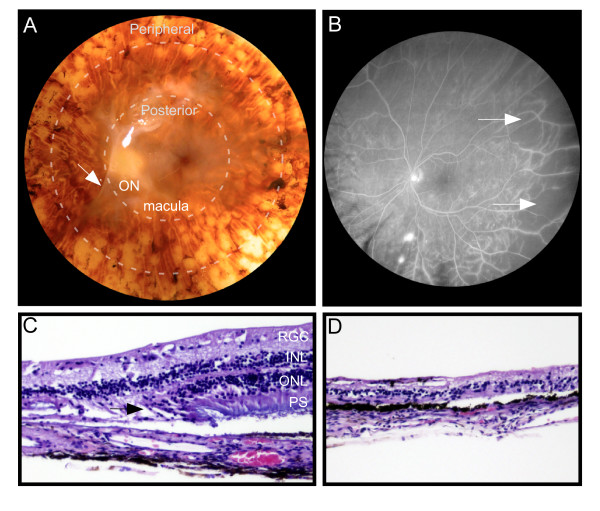
Regressed Proliferative Diabetic Retinopathy. A, Gross view of eye. There was a membrane (arrow) overlying the macula and optic nerve head (ON). Peripheral to this were laser photocoagulation scars. Dotted lines show the posterior and peripheral retina. B, Representative fluorescein angiogram showing capillary dropout (arrows) and peripheral ischemia. C, H&E section of the posterior retina shows variable cell and photoreceptor segment loss (arrow). D, H&E section of the peripheral retina shows extreme cell loss and disorganized cytoarchitecture. Abbreviations: H&E, heamotoxylin and eosin; ON, optic nerve; RGC, retinal ganglion cell layer; INL, inner nuclear layer; ONL outer nuclear layer; RPE, retinal pigment epithelium layer; PS, photoreceptor segments.